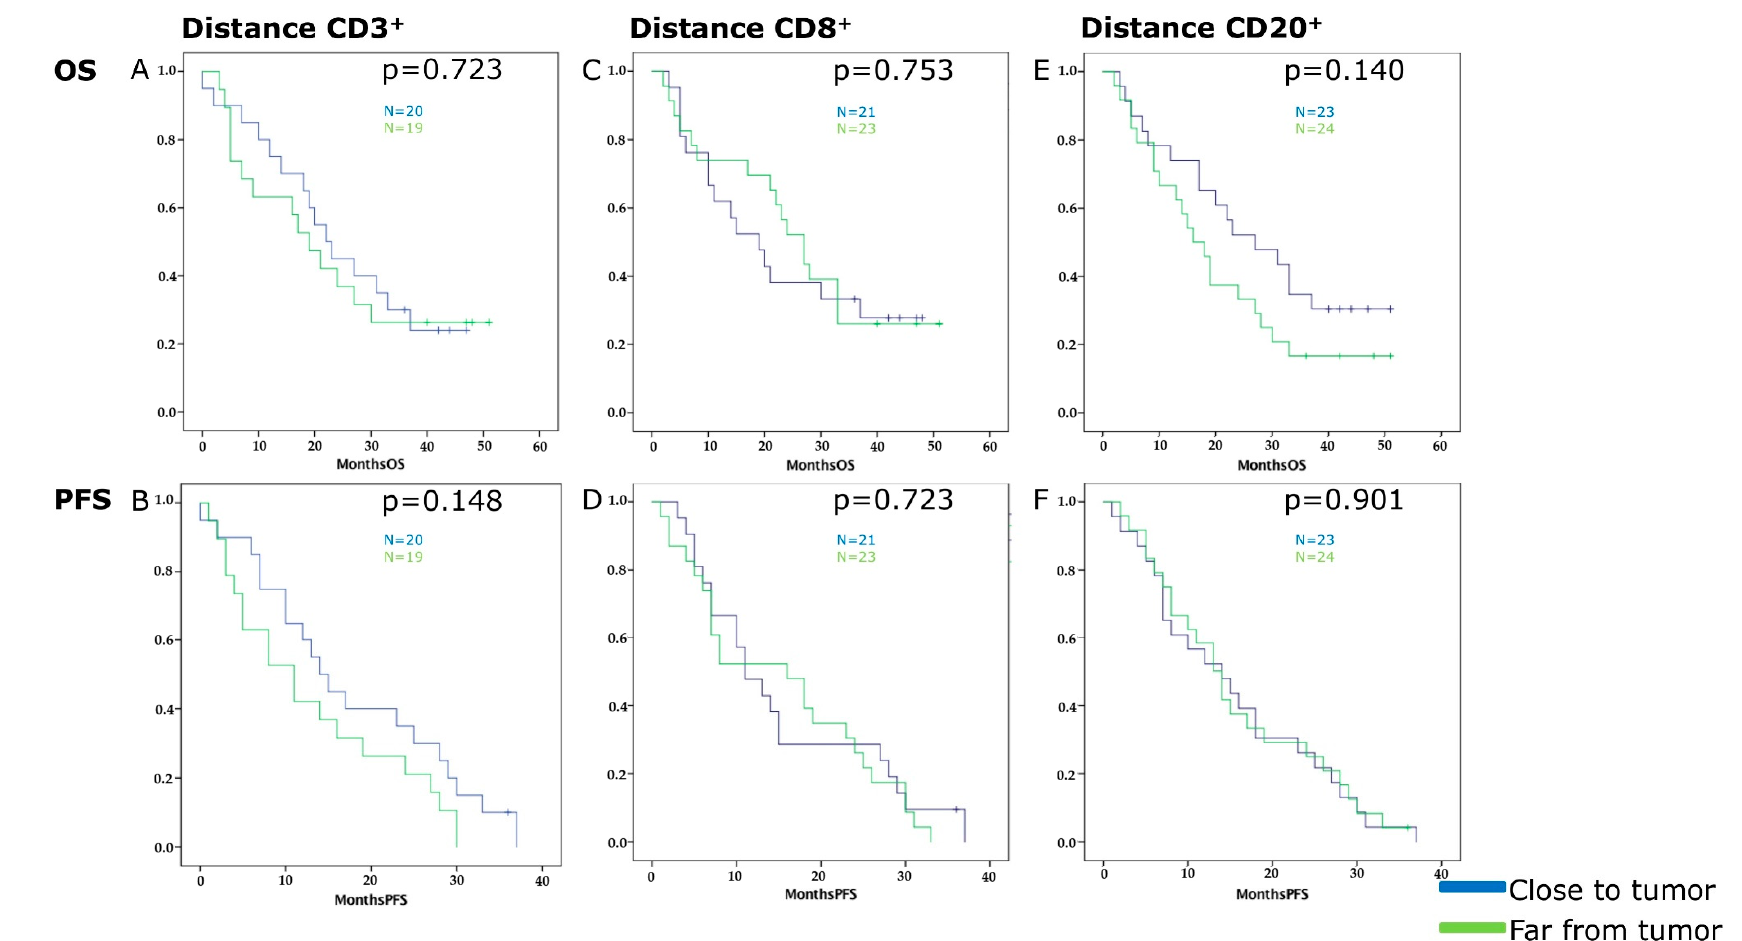
Figure 4. Kaplan-Meier survival curves of overall ( A , C , E ) and progression-free survival ( B , D , F ) in relation to the distance in µm of CD3 + ( A , B ), CD8 + ( C , D ) or CD20 + ( E , F ) hot spots from the tumor front. The groups are divided into hot spots close to the tumor front (blue) and hot spots far from tumor front (green) according to the median distance value: 0.0333253 µm for CD3, 0.0687577 µm for CD8, and 0.056765 µm for CD20.